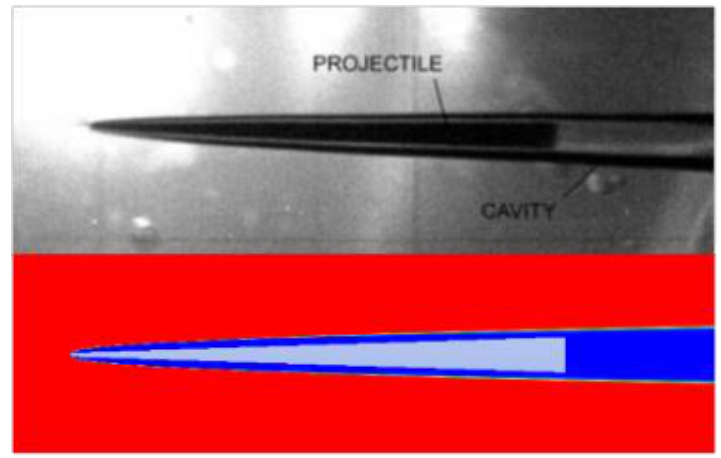
Figure 5. Comparison diagram of the velocity v = 970 m/s test and simulation cavitation flow field.